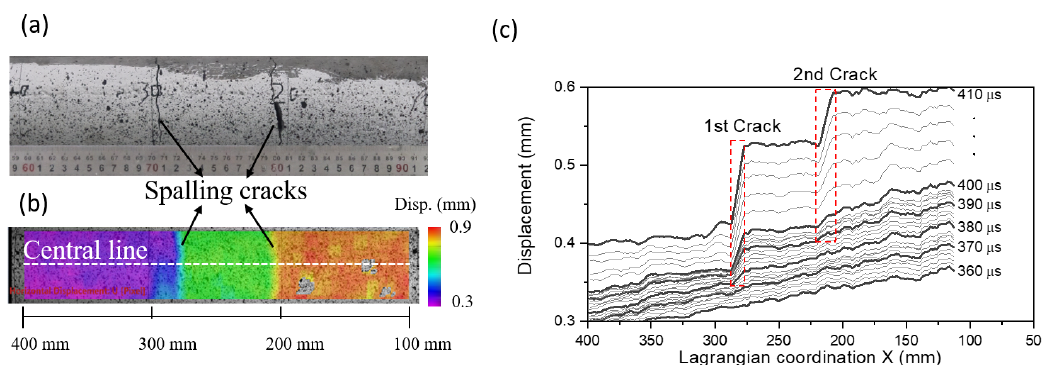
Figure 9. Results of particle displacements and crack profiles in the spalling test at a relatively low loading rate (7 m/s): ( a ) Two spalling cracks are identified in the specimen after the test; ( b ) The particle-displacement field shows two discontinuities at the locations of spalling cracks. The particle-displacement field is characterized by the ultra-high-speed imaging and DIC method. The color scale represents the values of particle displacement; and ( c ) comparing the particle-displacement profiles during t = 360 to 410 µ s shows that the left crack initiates earlier than the right one in ( a